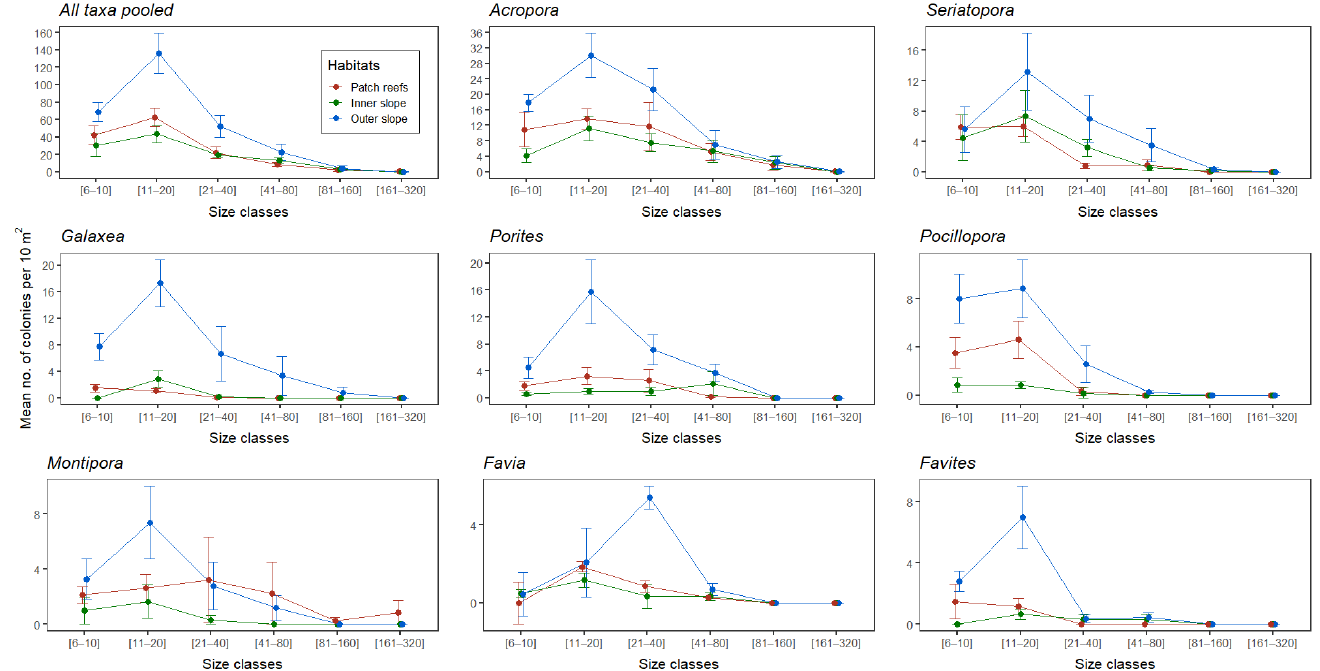
Figure 8. Size-structure of the eight major coral genera at each of the three major habitats (PR: patch reefs, IS: inner slope, and OS: outer slope) surveyed (all stations pooled). Error bars represent standard error.